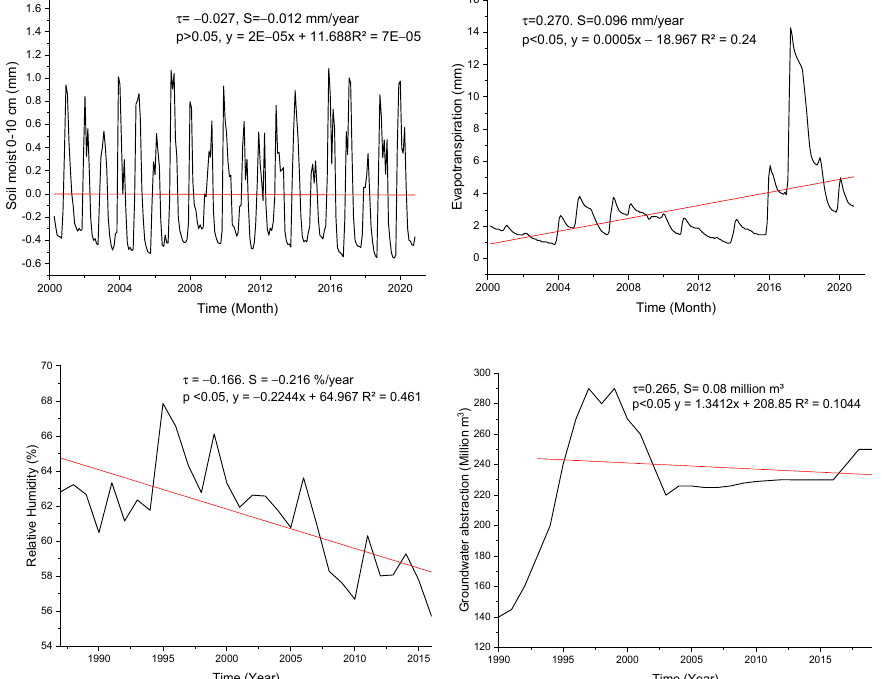
Figure 11. Long-term trends of soil moisture from GLDAS (A); relative humidity 1987–2016 and evapotranspiration from GLDAS (C); groundwater extraction (D) 1990–2019 (PSA, evapotranspiration from GLDAS (C); groundwater extraction (D) 1990–2019 (PSA, 2019).